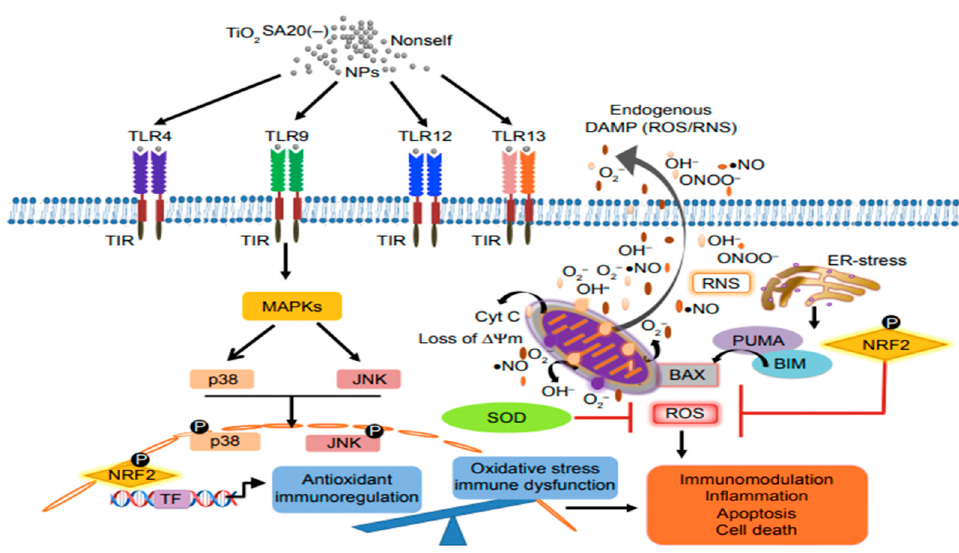
Figure 5. Mechanism of TiO 2 NP-induced immunotoxicity in cells (TLR = Toll-like receptor; MAPK = mitogen-associated protein kinase; JNK = c-jun N-terminal kinase; NRF2 = nuclear factor erythroid 2 factor 2; and SOD = super oxide dismutase). Adapted with permission from [84]. Copyright, 2018 Dove Medical Press Limited.